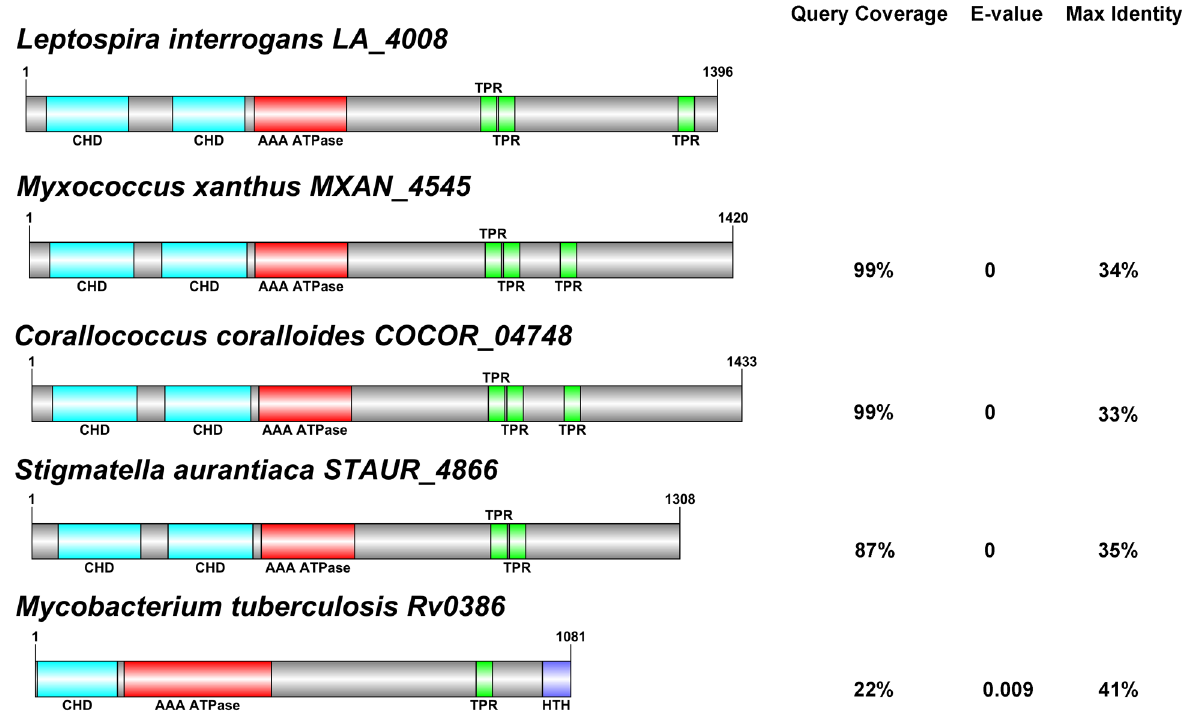
Figure 3. Ortholog sequence analysis of pathogenic Leptospira adenylate/guanylate cyclase compared to predatory environmental bacteria and the pathogen, Mycobacteriumtuberculosis . Domain architecture comparison of LA_4008 with orthologs of Myxococcus xanthus , Corallococcus coralloides , Stigmatella aurantiaca , and Mycobacterium tuberculosis using NCBI CD Search, SMART, and TPRPred. Protein homology analysis was carried out using BLAST using the following reference sequences: LA_4008 (NP_714188.1), MXAN_4545 (YP_632713.1),